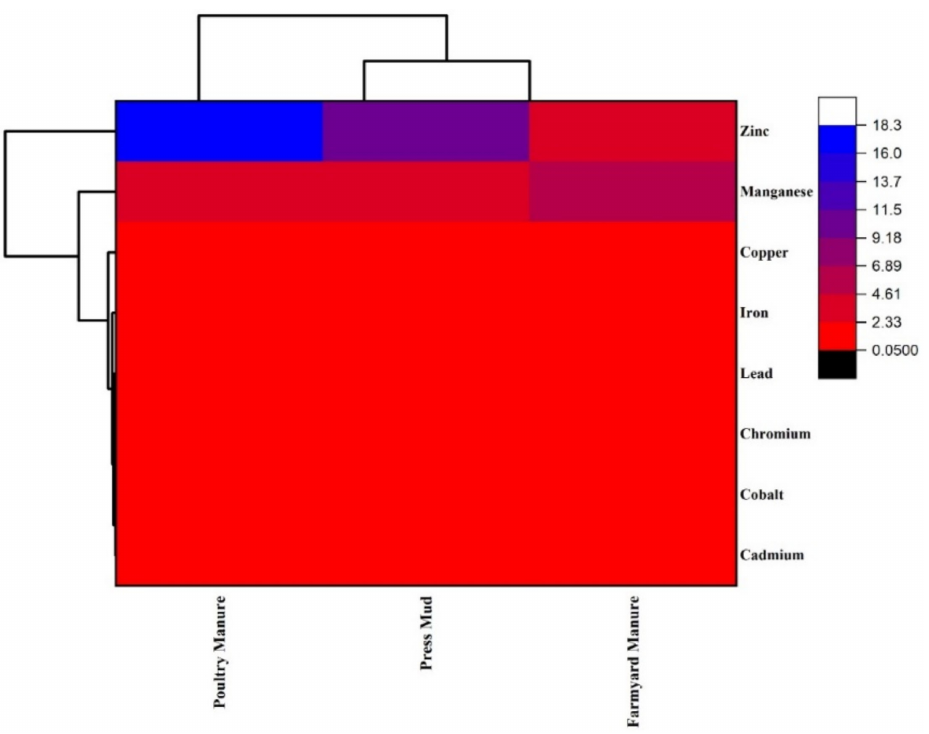
Figure 4. Dendrogram of 8 metals (copper, cobalt, chromium, cadmium, lead, iron, manganese, zinc) based on different treatment groups (poultry waste, press mud, and farmyard manure) from garlic plant. It was generated with a hierarchical cluster analysis with Average Linkage (between